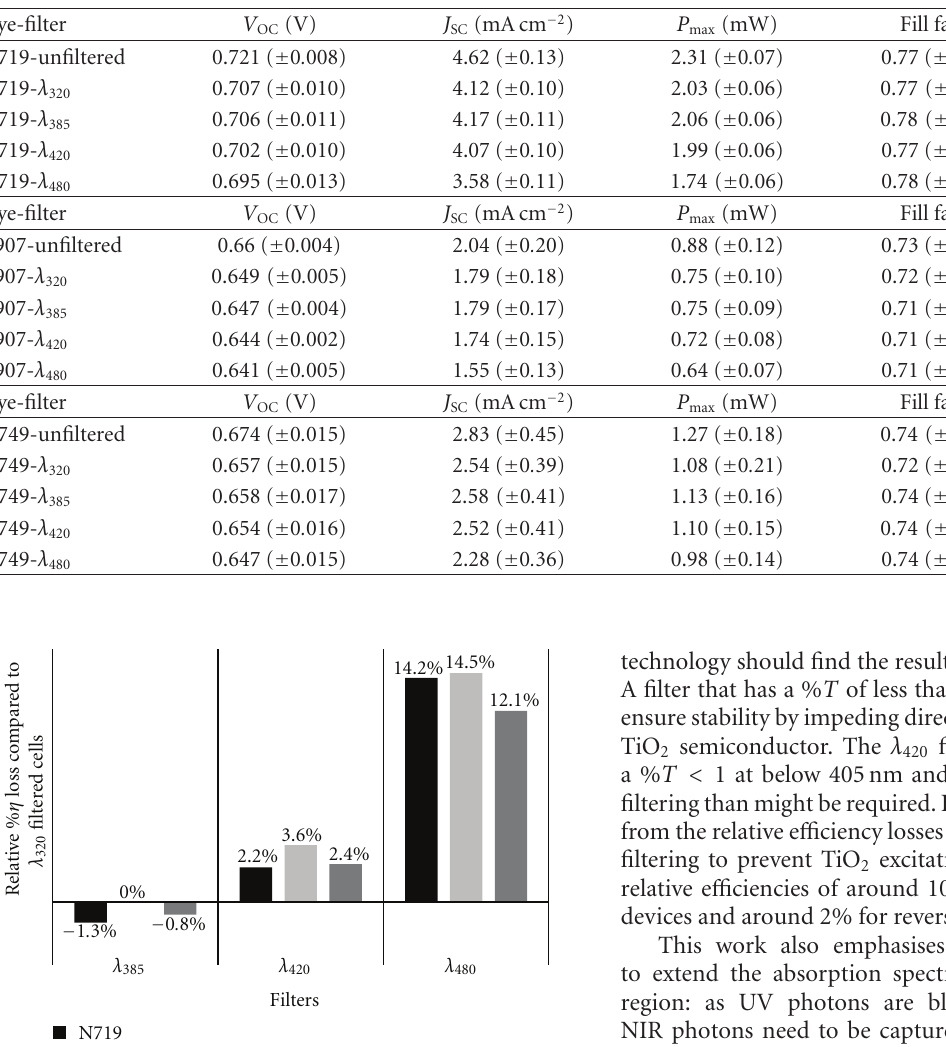
Table 4: Summary of I - V data for filtered and unfiltered, reverse illuminated cells.